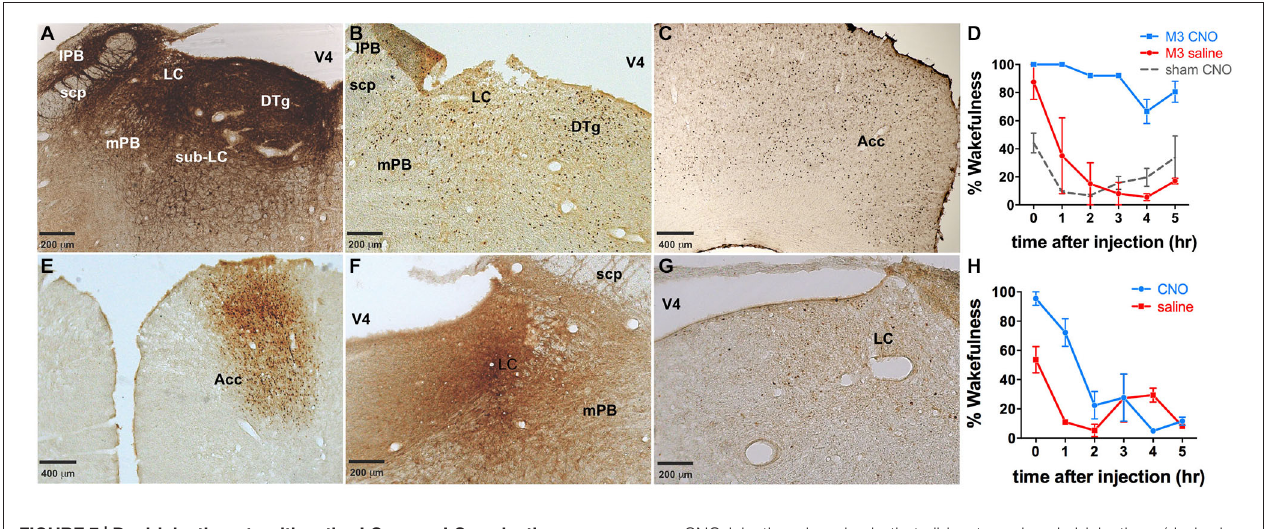
FIGURE 7 | Dual injections to either the LC or an LC projection. (A) Dual injection of CMV-Cre-AAV and hM3Dq-AAV into the LC results in widespread expression of hM3Dq throughout the pons. (B,C) Widespread c-Fos expression throughout the pons (B) as well as the cortex (e.g., ACC, (C) was observed following CNO administration. (D) Wakefulness is increased in animals receiving this dual injection following CNO administration (blue line), whereas neither saline in these animals (red line)